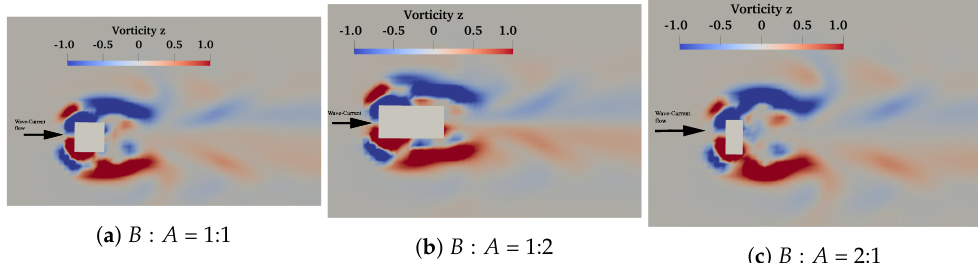
Figure 14. Vorticity contours for KC number = 10 and wave − current parameter ( U cw = 0.4) for varying aspect ratios of the rectangular